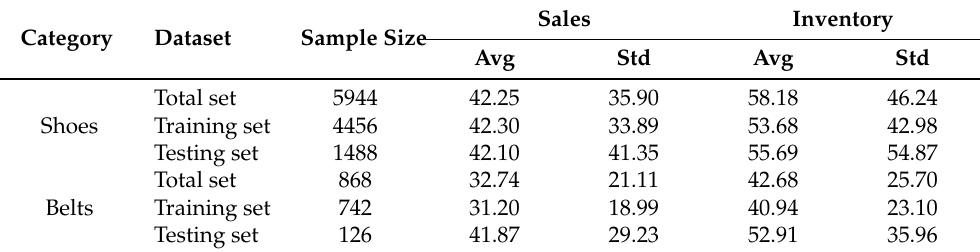
Table 1. Description statistics of the data sample in the dataset on shoes and